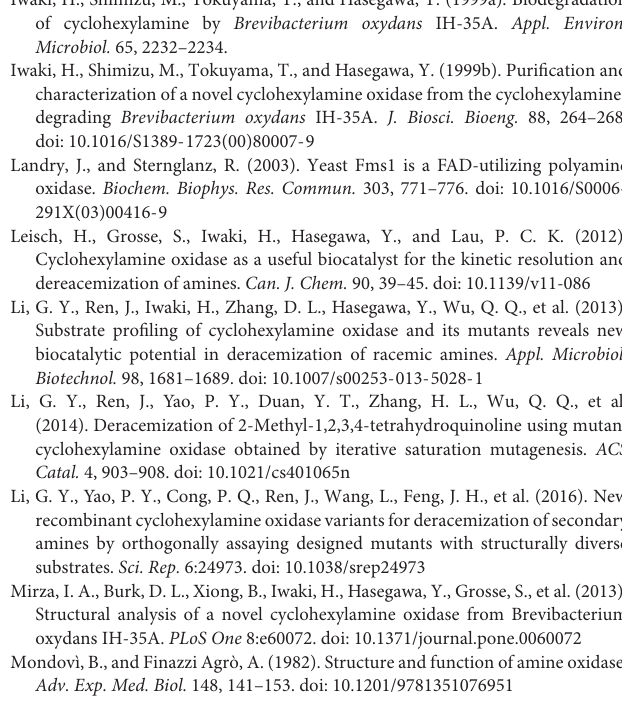
FIGURE S1 | Nucleotide sequence of the gene CF596 _10820. A putative promoter region was assigned to nucleotides 49–54 (TTGAAT) for the -35 region, and nucleotides 72–77 (TATACT) for the -10 region. The -10 and -35 regions of the promoter are underlined. The translation start codon for the CF596 _10820 is shown as the first methionine downstream from T for the transcription start site and GGAGAG for the ribosome binding site (S.D. sequence) (underlined). (A) Nucleotide and deduced amino acid sequence of 5 (cid:48) flanking regions of cyclohexylamine oxidase gene from Acinetobacter sp. YT-02. (B) Gene sequence chromatogram data for pET-28b- chao (sequencing from T7 promoter primer). (C) Gene sequence chromatogram data for pET-28b- chao (sequencing from T7 terminator primer). FIGURE S2 | Determination of CHAO YT − 02 molecular mass by gel filtration chromatography. The column was equilibrated with 10 mM phosphate buffer, pH 7.4, containing NaCl 140 mM. The column was calibrated with apoferritin from equine spleen (443 kDa), alcohol dehydrogenase (150 kDa), bovine albumin (66 kDa) and carbonic anhydrase (29 kDa) (Sigma-Aldrich, United States). V o = 8.049 ml, which was determined by the elution volume of blue dextran (2000